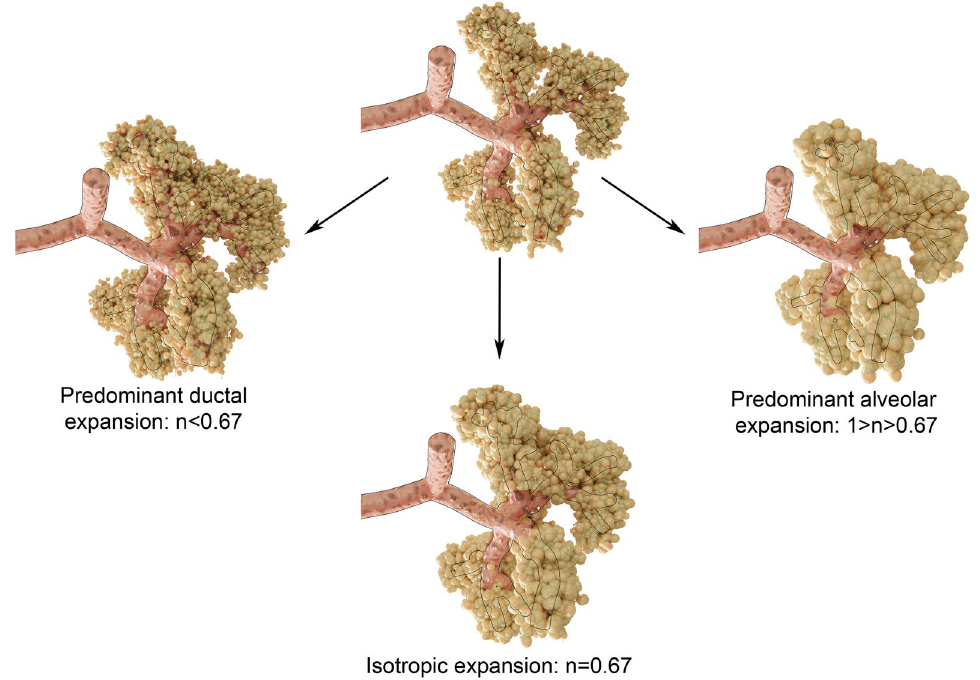
Figure 5. Schematic representation of how different acinar conformational changes translate into the exponent n in S = kV n . Thin black lines delineate approximate alveolar ductal size. Isotropic balloon like expansion results in S = kV 2/3 , while a predominantly ductal expansion (50% increase in radius) would cause n to be < 2/3 or < 0.67, and a predominantly alveolar expansion (50% increase in radius) would increase n >